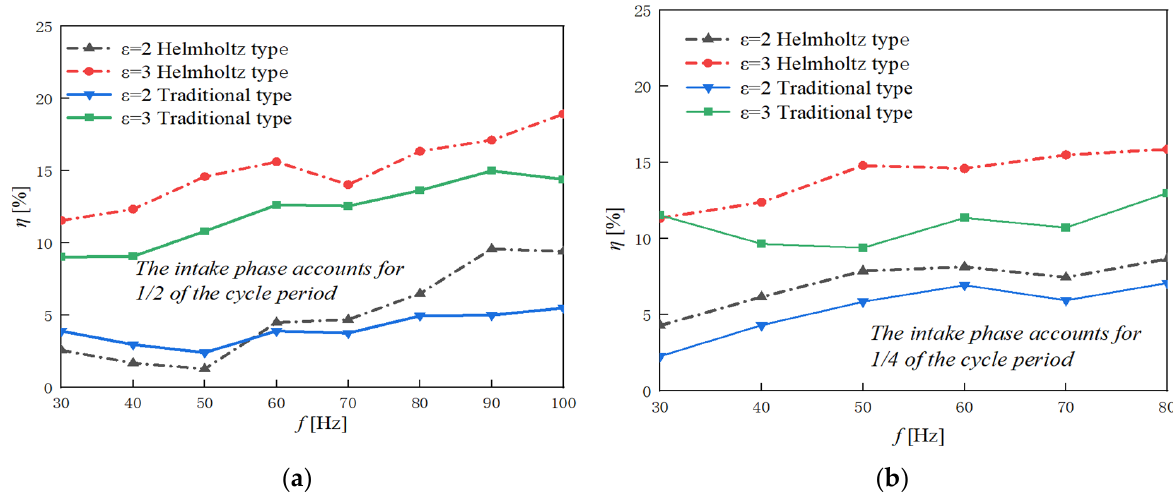
Figure 15. Refrigeration efficiency change diagram with frequency: ( a ) 1/2 duty cycle; ( b ) 1/4 duty cycle.